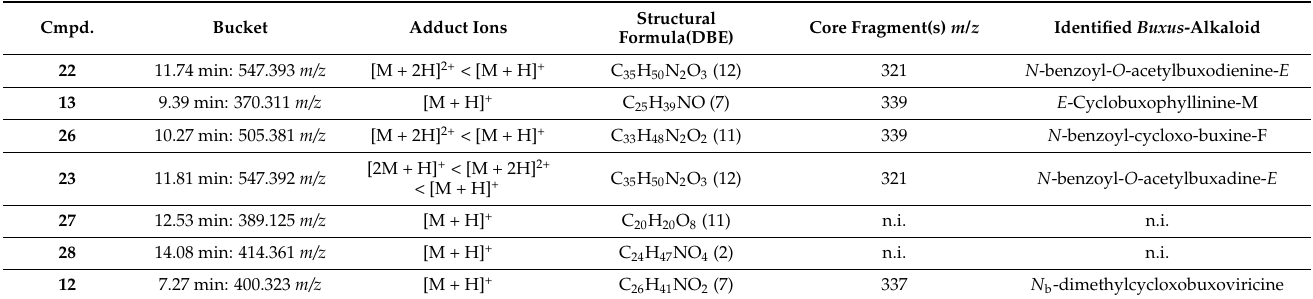
Table 2. LC/MS-characteristics of compounds with great variance (compare Figure